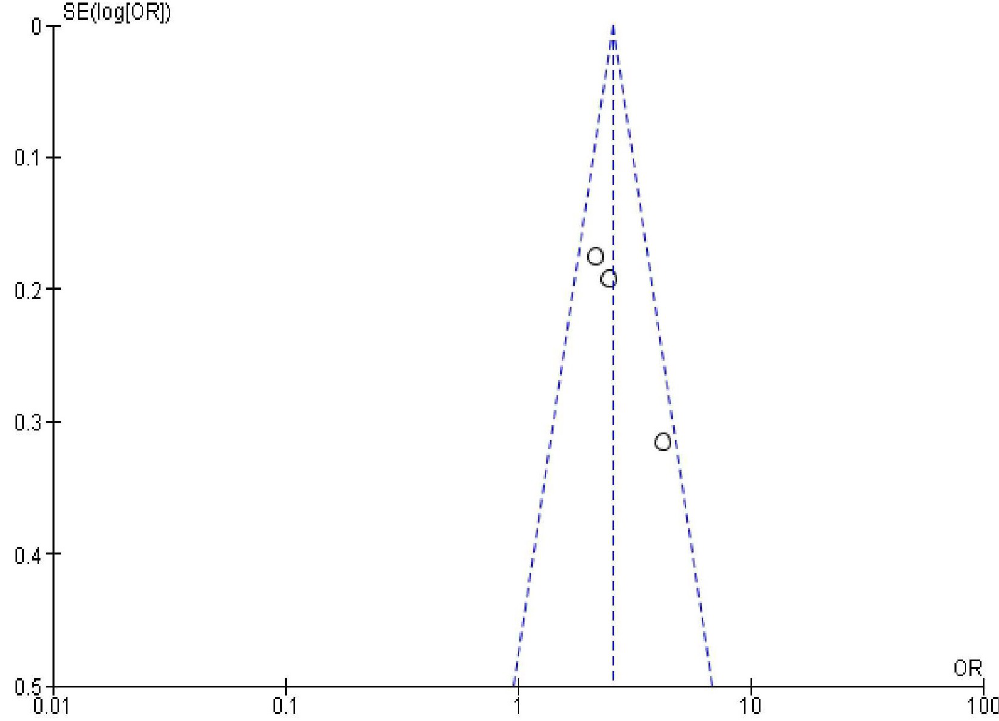
Fig 17. Publication bias on discussing FP methods with partner.